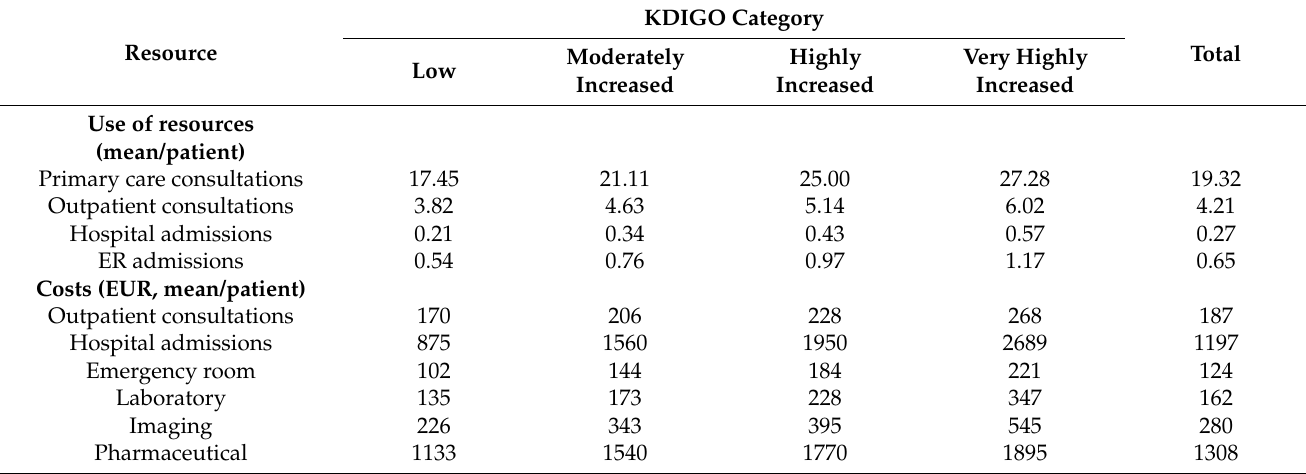
Table 3. Use of healthcare resources in patients with T2D and CKD according to KDIGO categories [30,31].